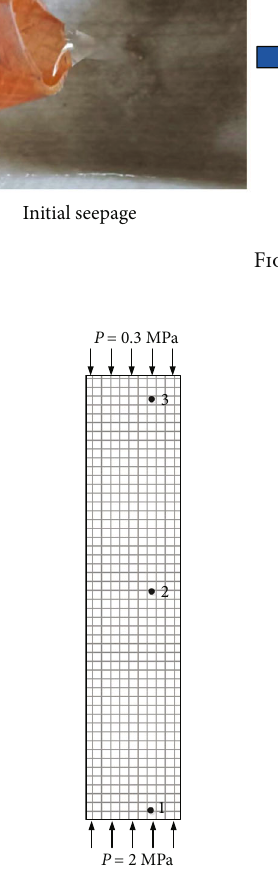
Figure 9: Numerical computation model.